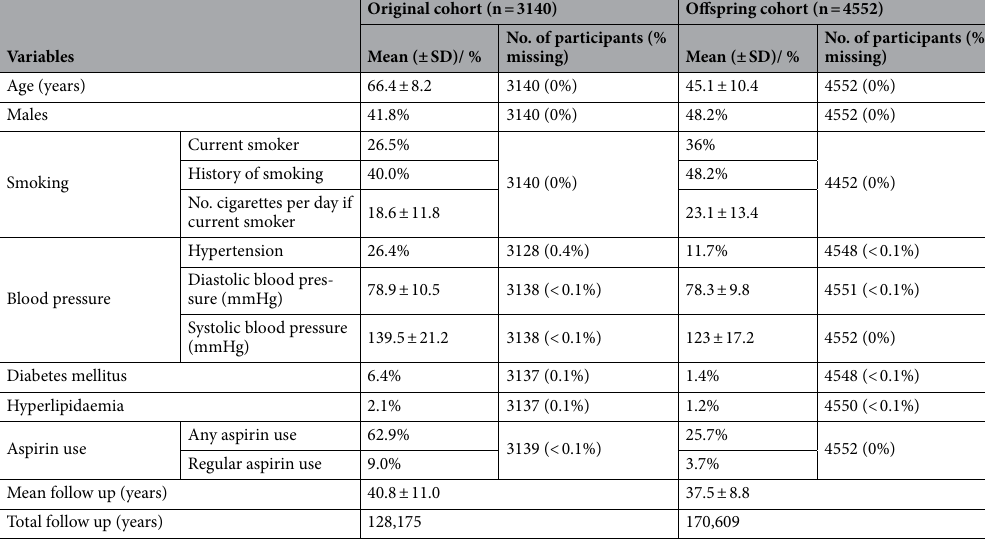
Table 1. Descriptive statistics of baseline variables included in this study. SD Standard